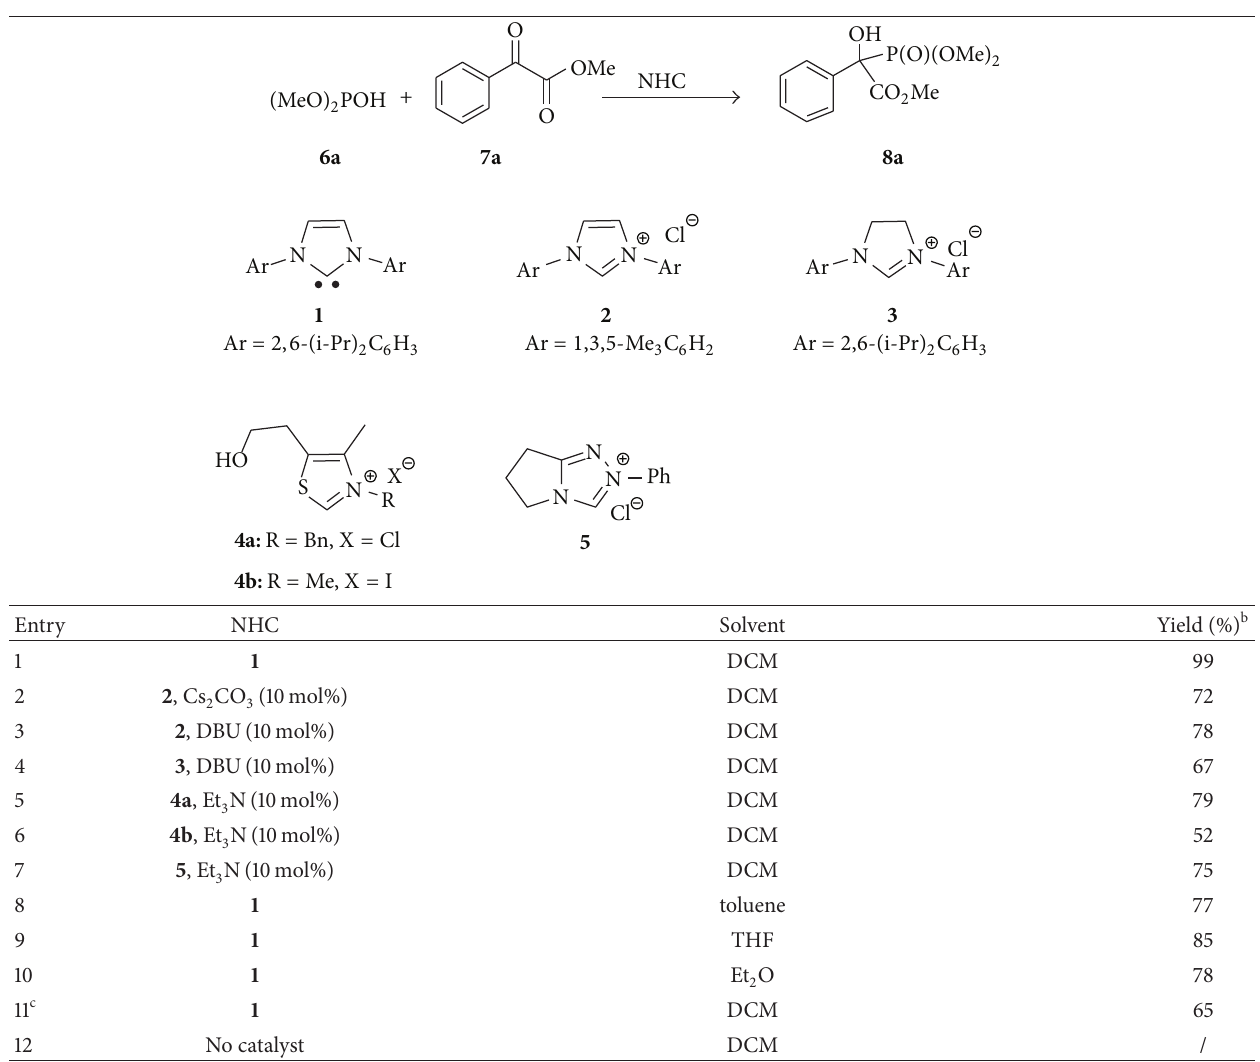
Table 1: Screening of reaction conditions a